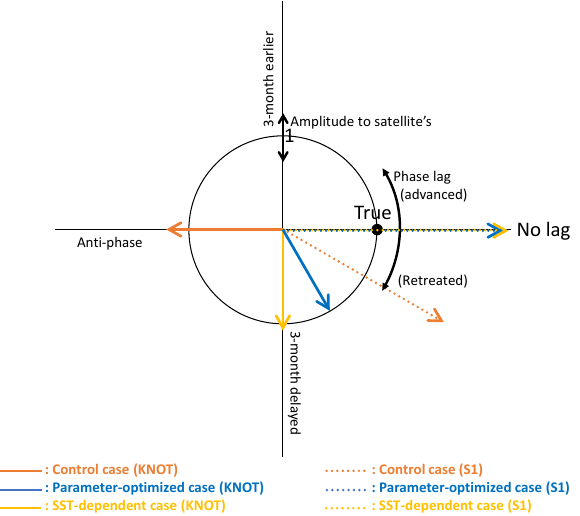
Figure 9. Diagram showing the amplitude and the phase of sea- sonal variations in the three model cases compared with those in the satellite data. Based on the seasonal variation in the satellite data, the radius indicates the relative amplitude (model/satellite) of seasonal variation for each model case and the angle from the pos- itive x axis shows the time lag of the maximum concentration for each model case (i.e. the point (1, 0) shown as “true” is a match within 1 month and a 30 ◦ error range to the satellite data). The blue dotted line (parameter-optimized case at S1) and yellow dotted line (SST-dependent case at S1) overlap on the no-lagged x axis.